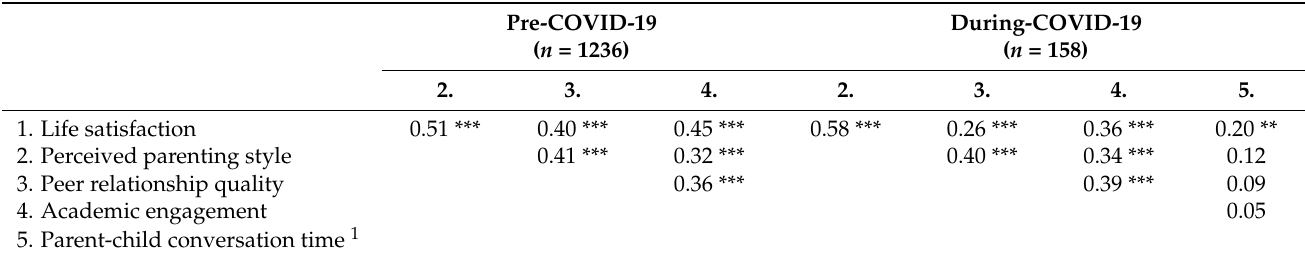
Table 3. Pearson correlations of perceived parenting style, peer relationship quality, academic engagement, parent-child conversation time, and life